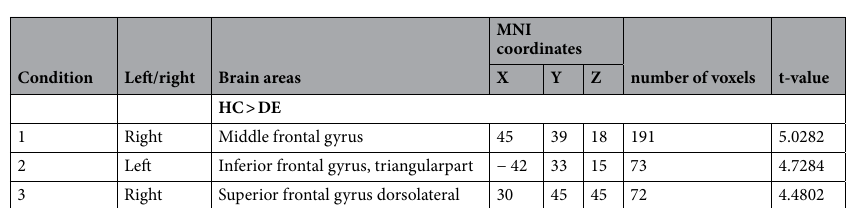
Figure 2. Mean ReHo values of altered brain regions. Compared to HC subjects, the ReHo values of the following regions were decreased in DE patients: triangular part of the IFG (IFGtriang.L; t = 4.7284), MFG (MFG.R; t = 5.0282), and dorsolateral SFG (SFGdor.R; t = 4.4802). BA Brodmann’s area.